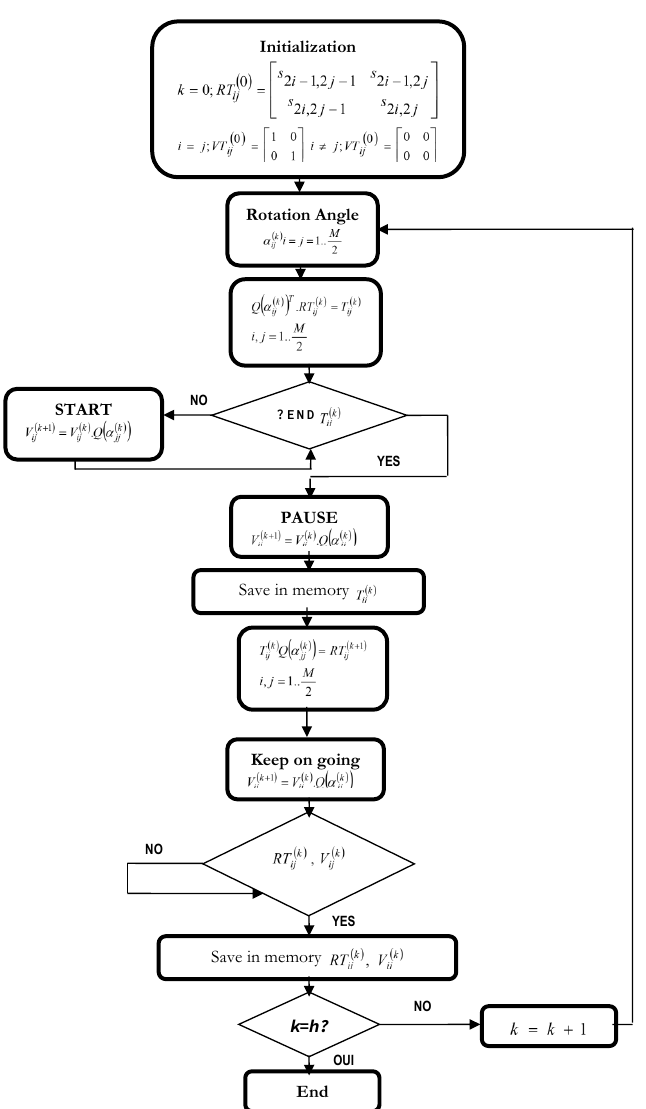
Figure 15. Flowchart for the calculation of vectors and